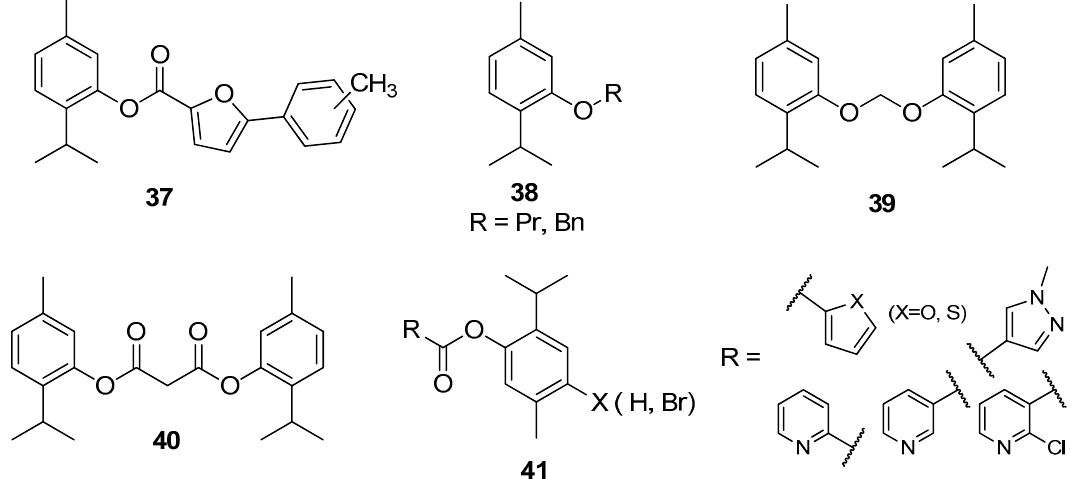
Figure 10. Selected thymol derivatives with significant antifungal activities.